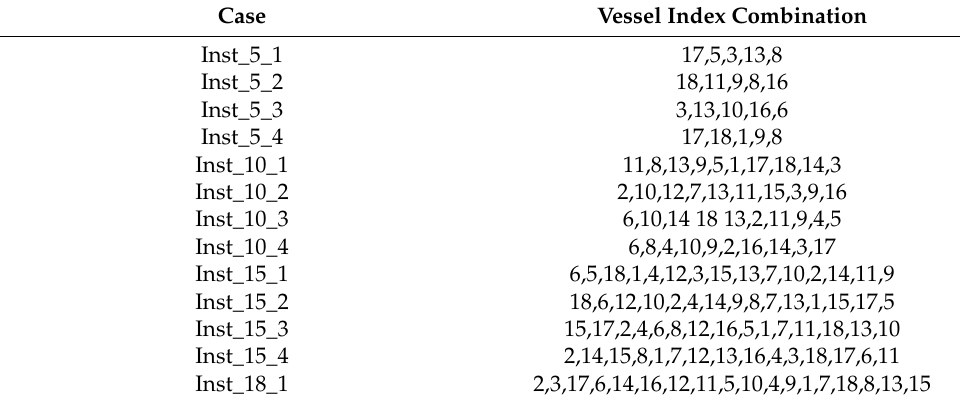
Table 8. Experimental